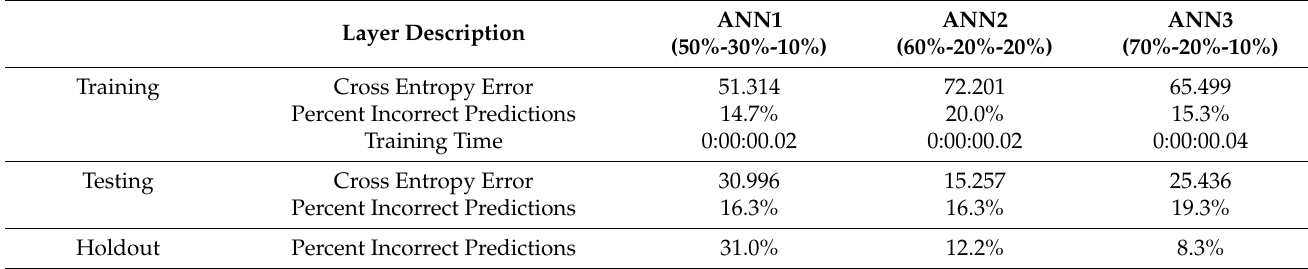
Table 4 summarises model fit for three ANNs. Table 4. Summary of the model fit for the three ANNs in training, testing, and holdout